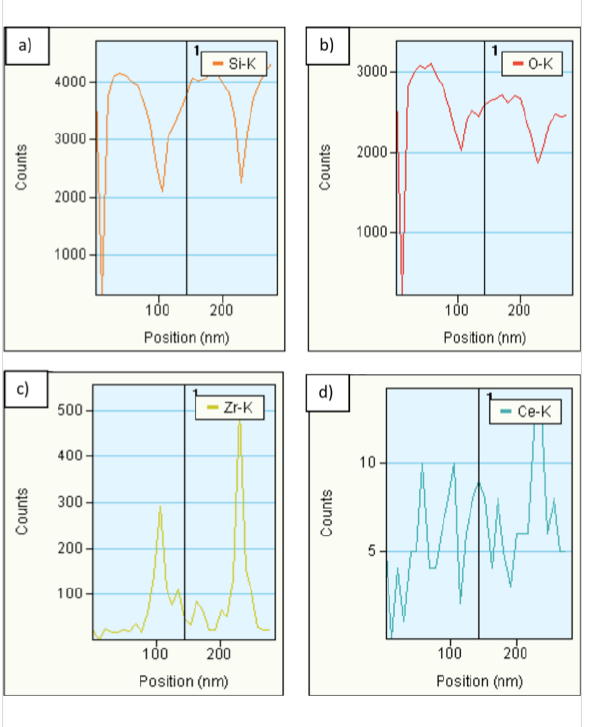
Figure 8: a–d) EFTEM, individual EDX profiles for the elements Si, O, Zr and